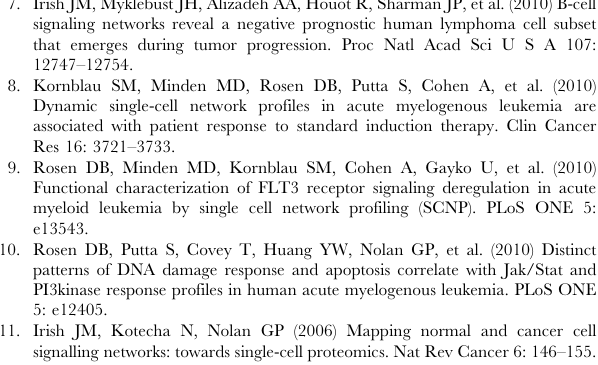
Figure S1 Gating scheme applied to B cells from CLL and healthy donors. Figure S2 H 2 O 2 amplifies BCR-mediated signaling in healthy B cells. PBMCs from healthy donors were either untreated or stimulated for 10 minutes with anti- m alone, H 2 O 2 alone or the combination. 2D flow plots of gated B cells show exemplary samples in which H 2 O 2 potentiates anti- m mediated signaling of proximal BCR effectors as previously reported [16]. Figure S3 H 2 O 2 treatment segregates CLL samples into two groups based on p-Stat 5 signaling in cell subsets. Changes in Stat 5 phosphorylation are shown in 2D flow plots and panels (A) and (B) show samples organized by their apoptotic response to in vitro F-ara-A exposure. (A) Stat 5 is phosphorylated in response to H 2 O 2 alone in a CLL B cell subset within this CLL sample sub-group. All samples with these Stat 5 responsive cells undergo F-ara-A-induced apoptosis. (B) Minimal Stat 5 phos-